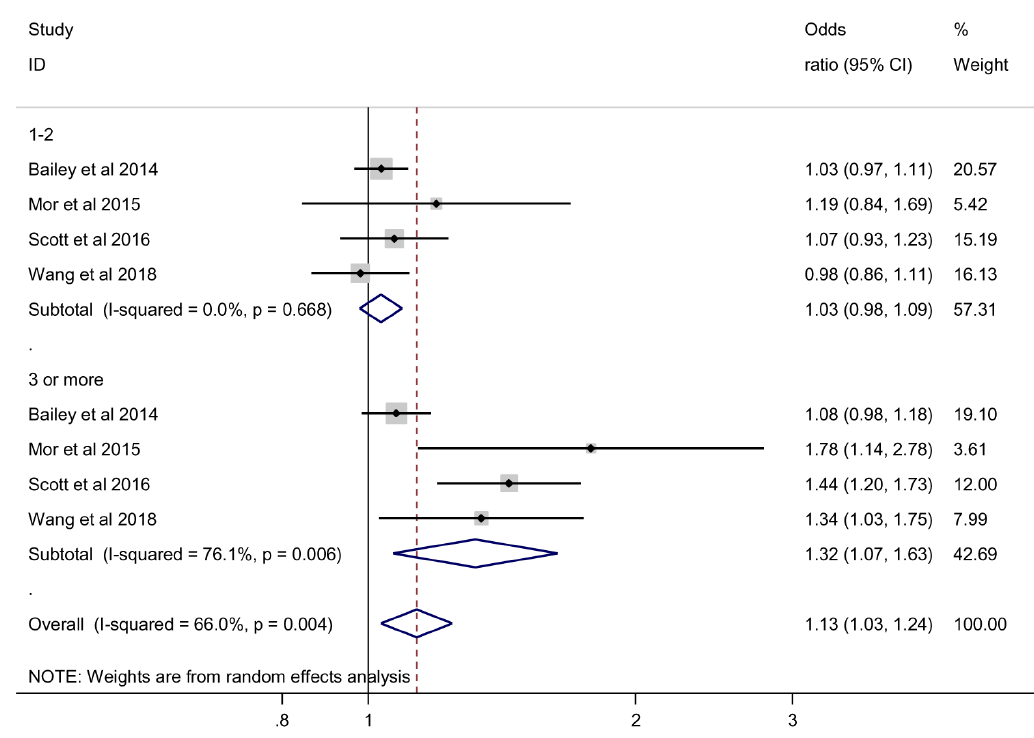
Figure 10. Obesity outcome, subgroup analysis by number of antibiotic